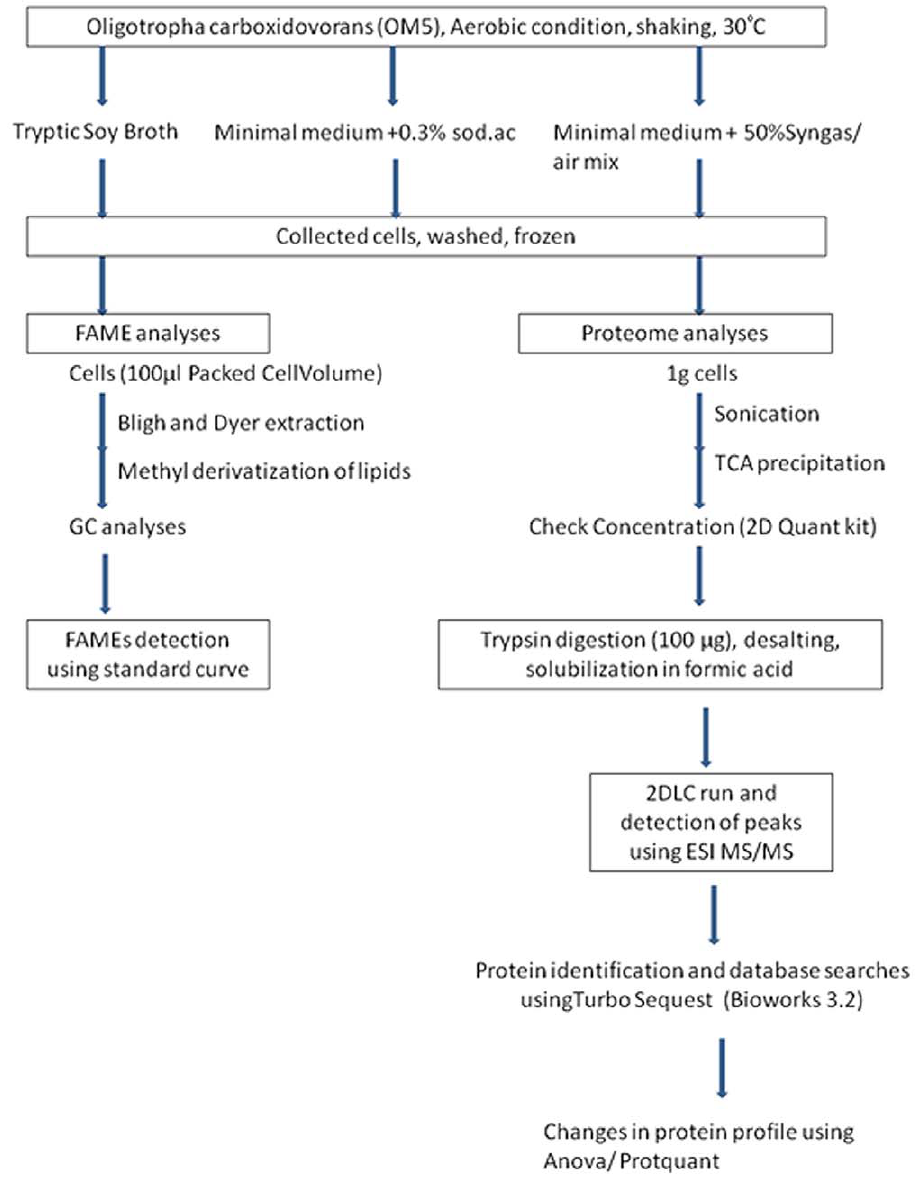
Figure 4. A flow diagram outlining the experimental workflow. doi:10.1371/journal.pone.0017111.g004 PLoS ONE |